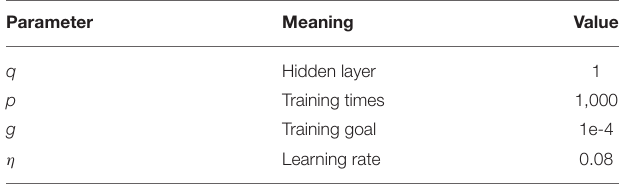
TABLE 3 | Common parameter settings in BPNN.